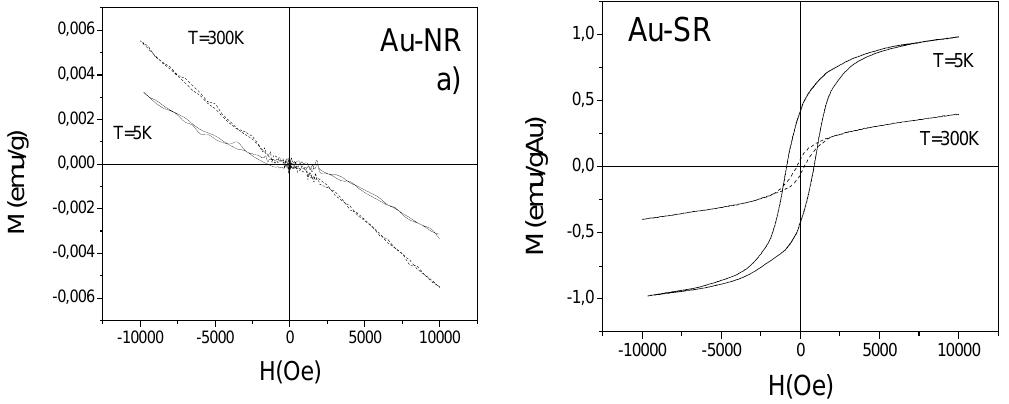
FIGURE 19 . Hysteresis loops from 1.4-n Au NPs capped with (left) tetraalkylammonium and (right) thiols. From ref.